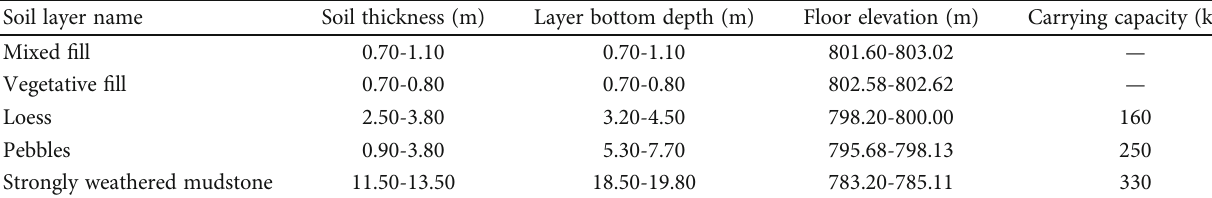
Figure 3: Risk assessment model of foundation pit construction. Table 6: The main parameters of the